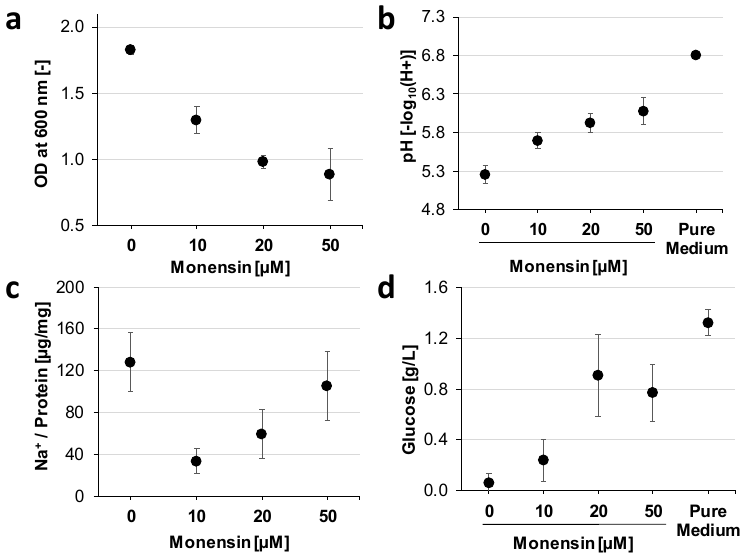
Figure 3. Glucose and glucose-6-phosphate in supernatant are displayed over time in two monensin conditions. Small letters indicate least significant difference (LSD) between time points for monensin group with p -values indicated in brackets. Measurements for 0 and 20 µM were significantly different ( p < 0.01). Measuring at 0 h was performed with non-inoculated medium. All measurements display the average as a dot and error bars as standard deviation (SD). ( a ) Optical density at 600 nm wavelength ( p < 0.01). ( b ) pH of cultivation media ( p < 0.01). ( c ) Extracellular glucose only with LSD-test for 20 µM ( p < 0.01). ( d ) Extracellular glucose-6-phosphate (G6P) only with LSD-test for 20 µM ( p < 0.05).